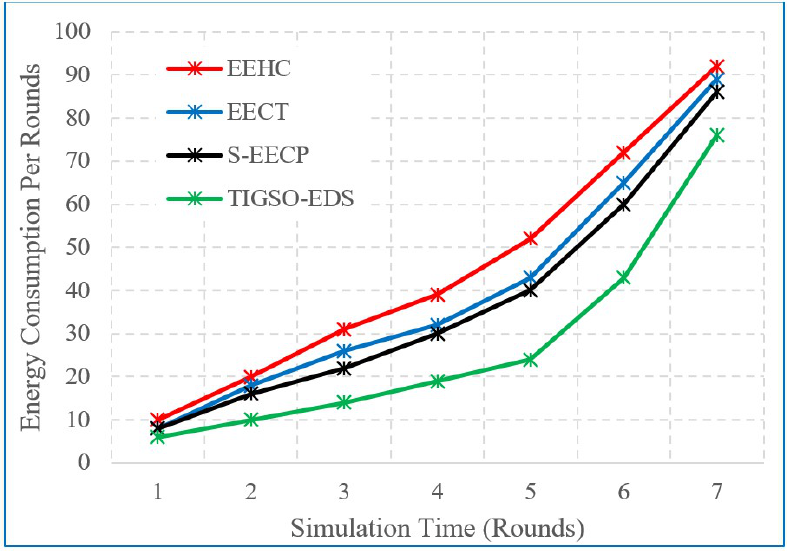
Figure 8. Energy consumption of different methods (base station located at 50 × 50).